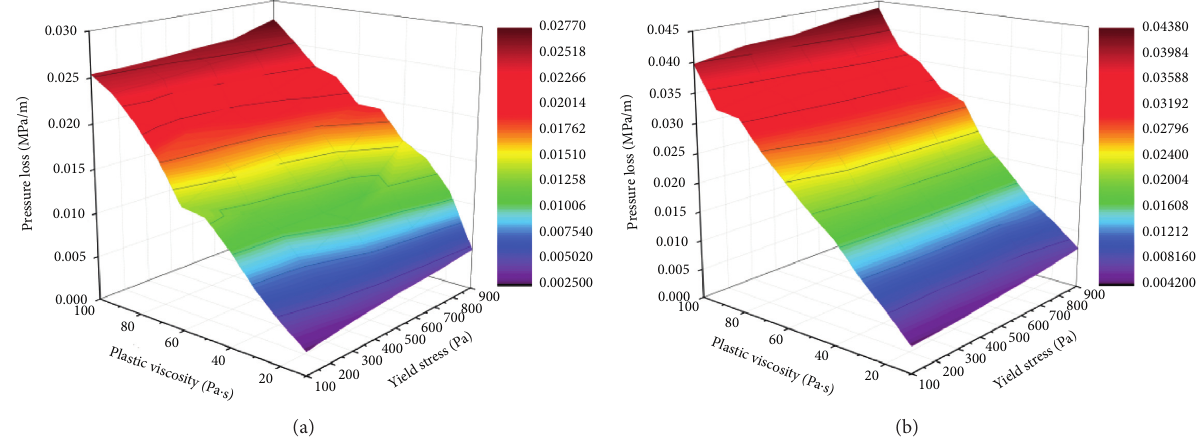
Figure 6: The change of pressure loss under different rheological parameters: (a) ϕ 150mm and (b) ϕ 125mm.